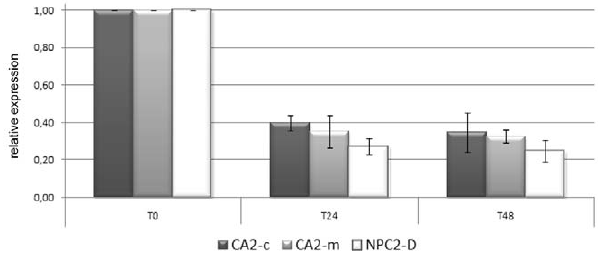
Figure 3. CA2-m, CA2-c, and NPC2-D expression in response to imposed thermal stress. Expression of CA2-m, CA2-c and NPC2-D after 0, 24 h and 48 h of 8 u C heat stress was measured using RT-qPCR. Three anemones (Sy3–5) were assayed. Gene expression, normalized to RCC2 and COP- c , is given related to t0. Error bars represent standard error.